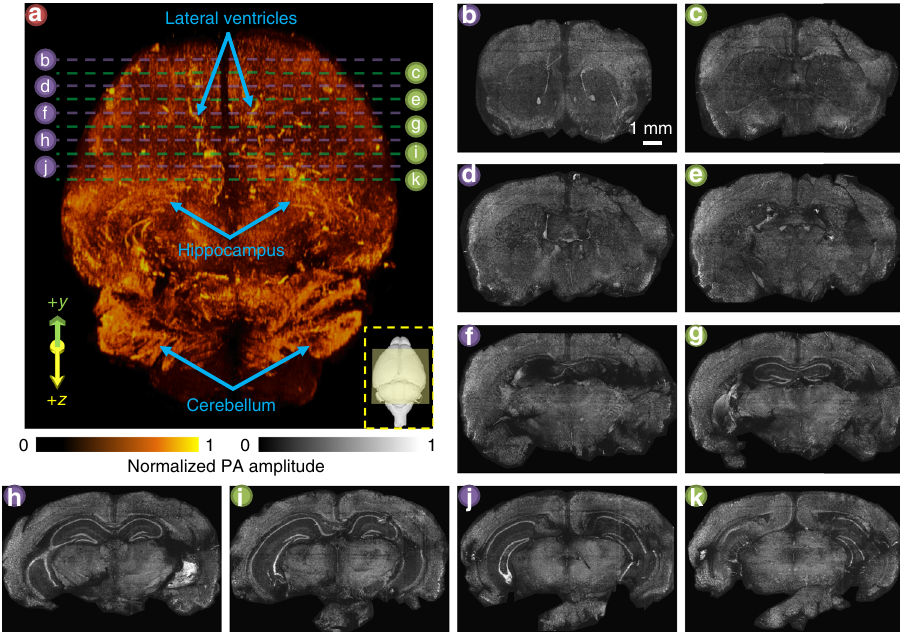
Fig. 3 3D label-free mPAM image of an unstained mouse brain embedded in an agarose block. a An mPAM volumetric image of a mouse brain with a sectioning step size of 200 µ m. The bottom right yellow dashed inset shows the corresponding projection and its imaging area (yellow shaded region) of a 3D mouse brain model (reprinted from Elsevier, Vol. 53, Johnson, G.A., Badea, A., Brandenburg, J., Cofer, G., Fubara, B., Liu, S. & Nissanov, J., Waxholm space: an image-based reference for coordinating mouse brain research, 365 – 372, copyright (2011), with permission from Elsevier) 33 . Three features, namely the lateral ventricles, hippocampus, and cerebellum, are labeled on the 3D mPAM image. b – k The relative positions of ten coronal views are labeled in a , and they are shown individually. The separation between each section is 500 µ